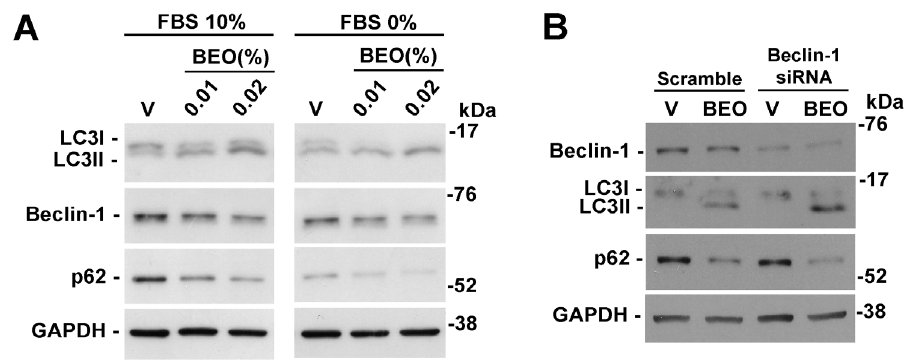
Figure 6. Stimulatory effects of BEO on autophagy still occur in serum-starved cells and overcome beclin-1 knockdown. ( A ) BEO enhances serum starvation-induced autophagy in SH-SY5Y cells. Neuroblastoma cells serum-starved for 24 h (FBS 0%) were exposed to BEO (0.01–0.02%) or vehicle (V, 0.018% ethanol) for 1 h. Protein extracts were analyzed by western blotting for LC3, Beclin-1 and p62 levels. GAPDH was used as internal control. Serum starvation induced autophagy in SH-SY5Y cells as demonstrated by increased LC3II/LC3I ratio and reduced p62 levels (V FBS 0% vs V FBS 10%); further lipidation of LC3 and p62 reduction was evident in BEO-treated starved cells (FBS 0%) as compared to cells maintained in normal culture conditions (FBS 10%). Images from normal and starved cells are from the same immunoblot that has been cut to remove irrelevant lanes. ( B ) BEO induces autophagy through a beclin-1 independent mechanism. SH-SY5Y cells were transiently transfected with specific beclin-1 siRNA or scramble non targeting sequence 48 h before treatment with BEO (0.02%; 1 h). Effective knockdown of the protein was confirmed by western blotting. Silencing of beclin-1 did not prevent LC3I/LC3II conversion and p62 reduction induced by BEO exposure (0.02%, 1 h). Immunoblot is representative of three independent experiments (V 5 vehicle, 0.018%